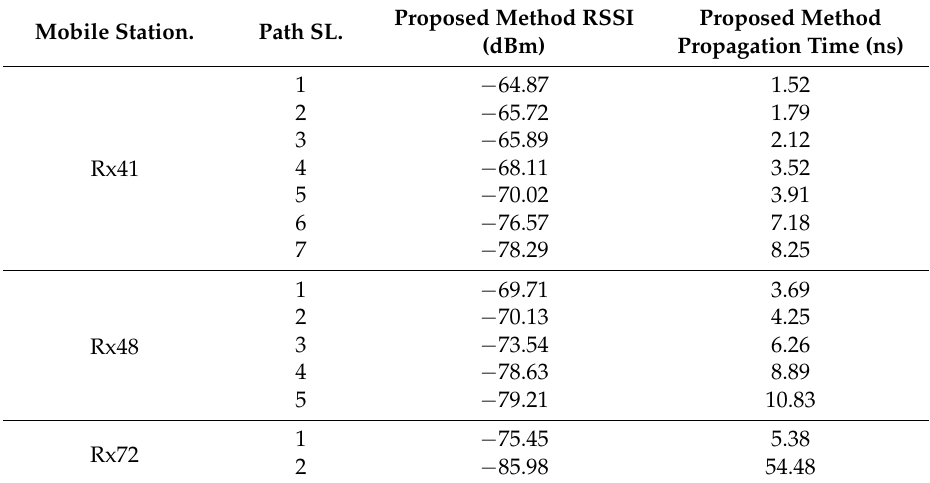
Table 6. Power delay profile for Rx41, Rx48, and Rx72 based on proposed method. Mobile Station. Path